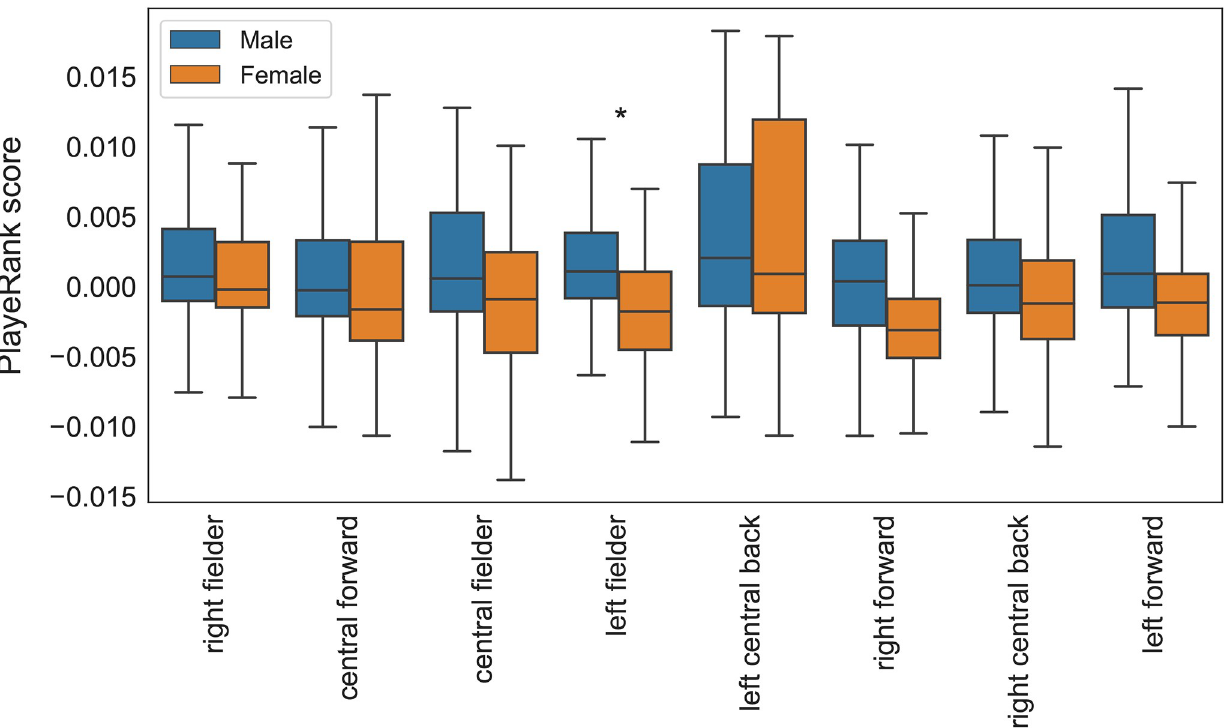
Fig 4. PlayeRank score by role fro male and female players. Asterisks indicate significant statistical difference between male and female for that role.